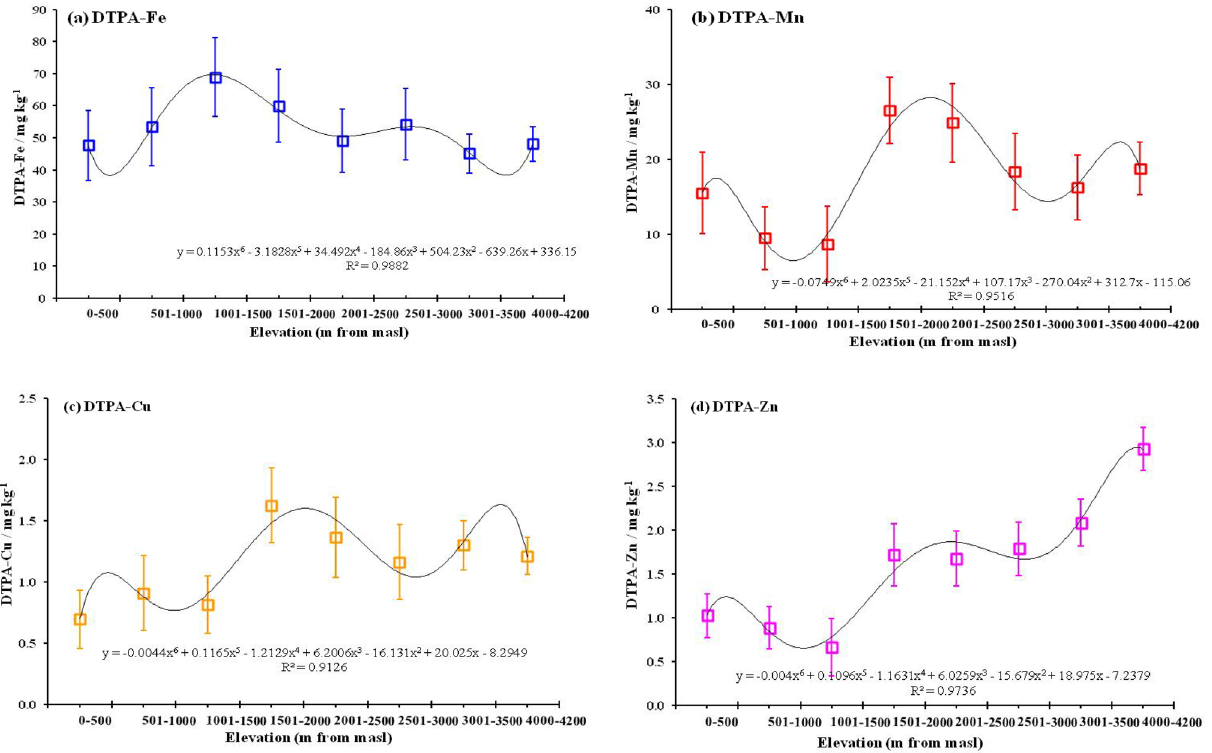
Figure 3. Altitudinal gradients (< 15 m to > 4000 m masl) on DTPA-extractable ( a ) Fe, ( b ) Mn, ( c ) Cu, and ( d ) Zn concentrations. Dotted lines are polynomial